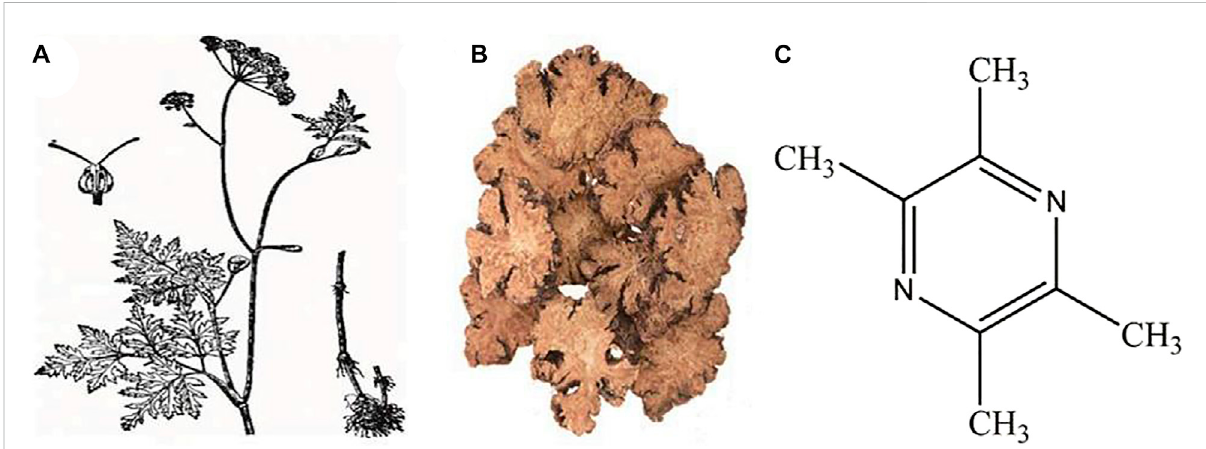
FIGURE 1 (A) Ligusticum striatum DC. (Chuan Xiong) plant; (B) Decoction pieces; (C) Chemical structure of tetramethylpyrazine [cited from Li J, Gong X. Front Pharmacol. 2022 Li and Tetramethylpyrazine